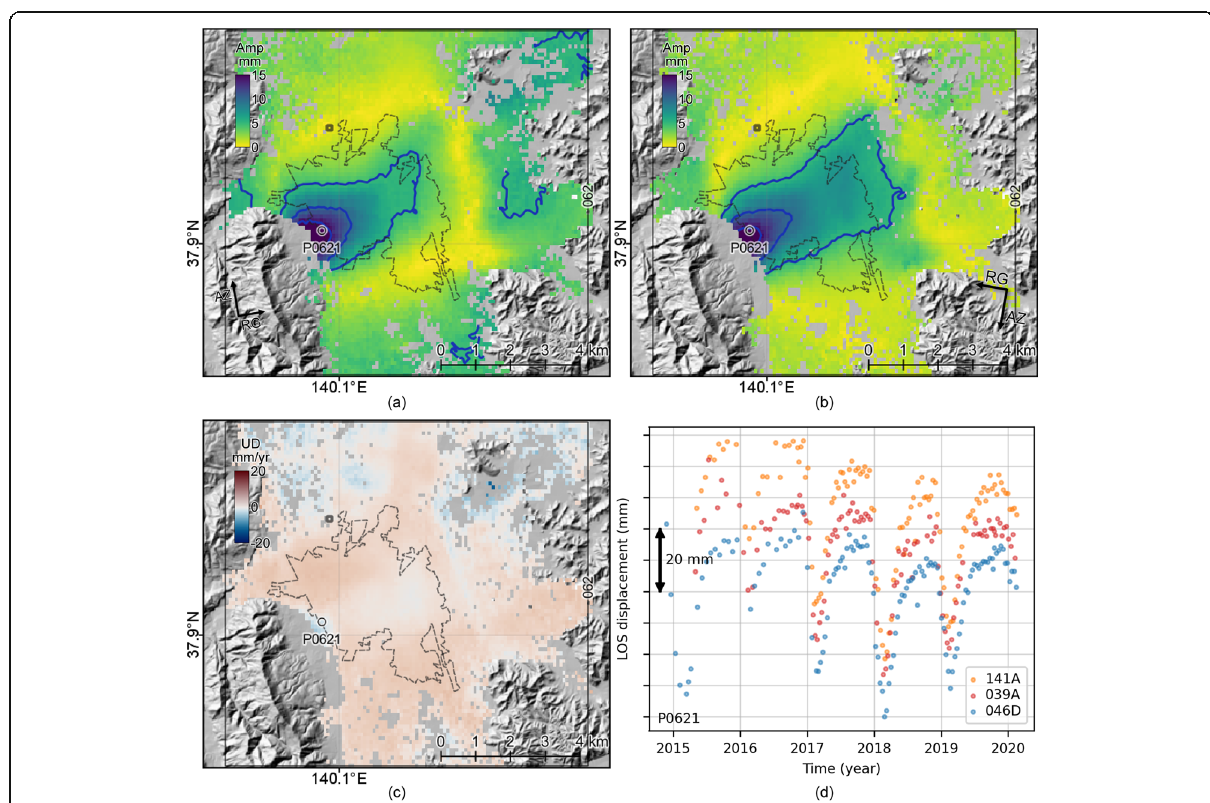
Fig. 7 a Amplitudes of the annual LOS fluctuation in Yonezawa (ID: 062) from the ascending 141A_05118_131311. The black lines denote the outlines of the DID. The interval of the contour lines is 5 mm. The black square denotes the reference point. b Amplitudes from the descending 046D_05096_121313. c Vertical deformation velocities. d LOS deformation time series at P0621 for each